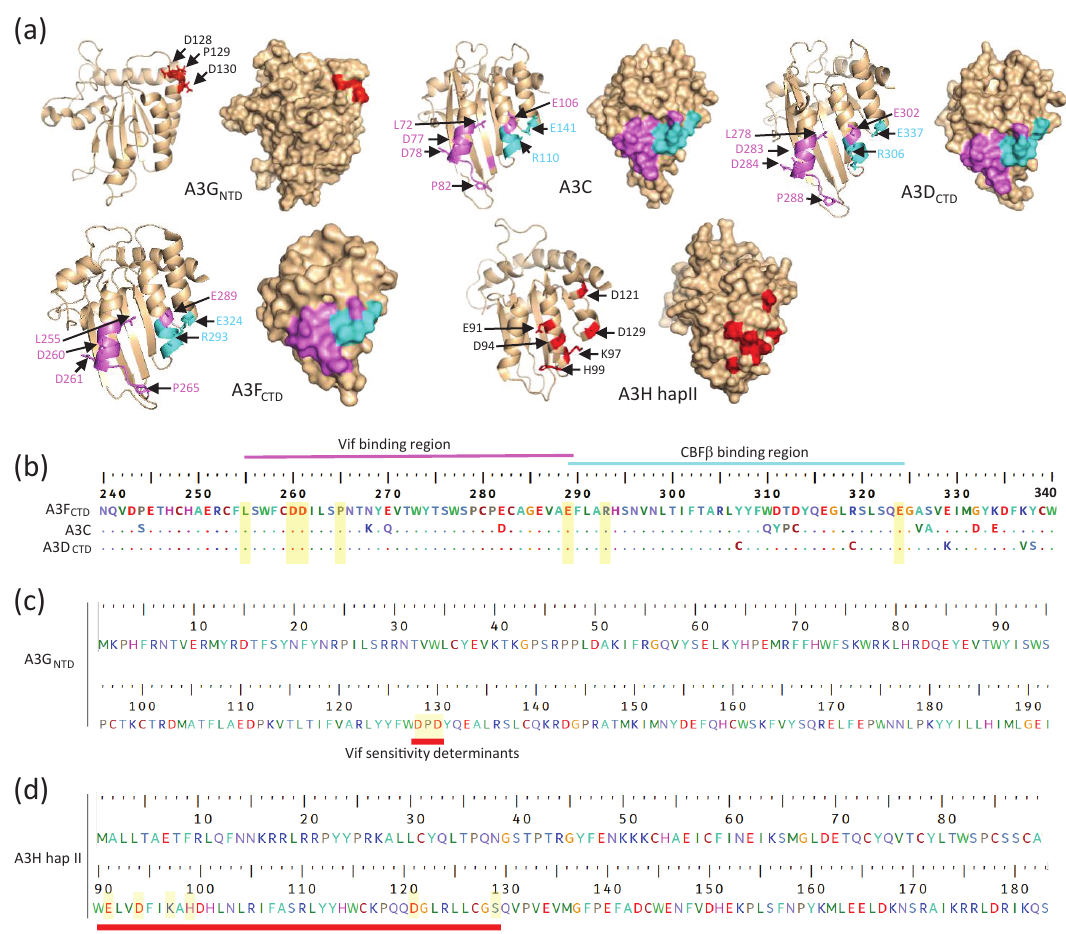
Figure 3. Comparison of A3G NTD , A3C, A3D CTD , A3F CTD , and A3H hap II structures. ( a ) Cartoon and surface representations of the structure of A3G NTD (PDB: 2MZZ), A3C (PDB: 3VOW), and A3D CTD (a predicted model generated through homology modeling based on the A3F CTD structure (PDB: 6NIL) by using the Phyre2 web portal for protein modeling, prediction and analysis [140], and A3H hap II (PDB: 6BBO). The known Vif-mediated degradation determinants labeled in red (for A3G and A3H), the critical residues for Vif-binding in magenta (for A3C, A3D, and A3F), and the CBF β binding residues in cyan (for A3C, A3D, A3F). ( b ) Multiple sequence alignment of A3 domains (A3F CTD , A3C, A3D CTD ) and the critical Vif- and CBF β -binding residues are highlighted in yellow bars. A3F was used as a reference and hence the numbering is based on A3F’s residue numbers. The determinants for Vif- and CBF β -binding are in non-overlapping regions, which are indicated above the alignment. ( c , d ) Similar primary sequences of residues in A3G NTD and A3H hap II are shown, respectively. The residues highlighted in yellow bars are identified to be critical for Vif-mediated degradation of the respective A3 proteins. The sequence alignment was performed by a Clustal W multiple alignment in